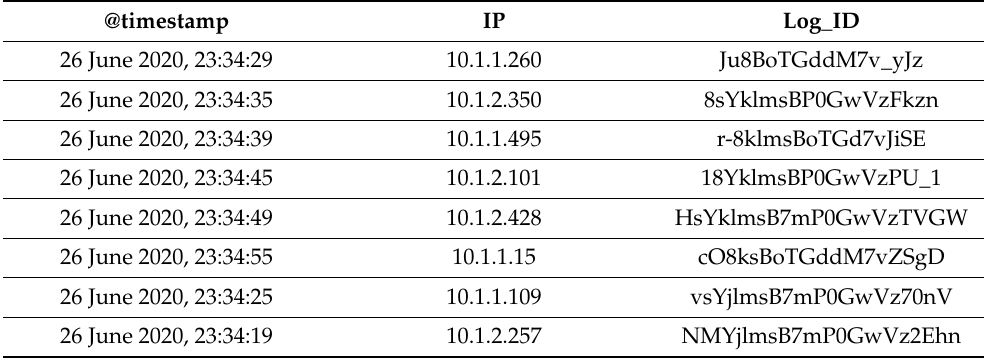
Table 3. Raw dataset features.